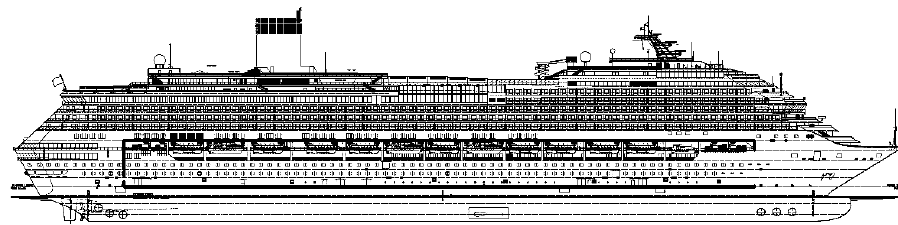
Figure 2. Profile view of the reference ship. Table 2. Main characteristics of the reference